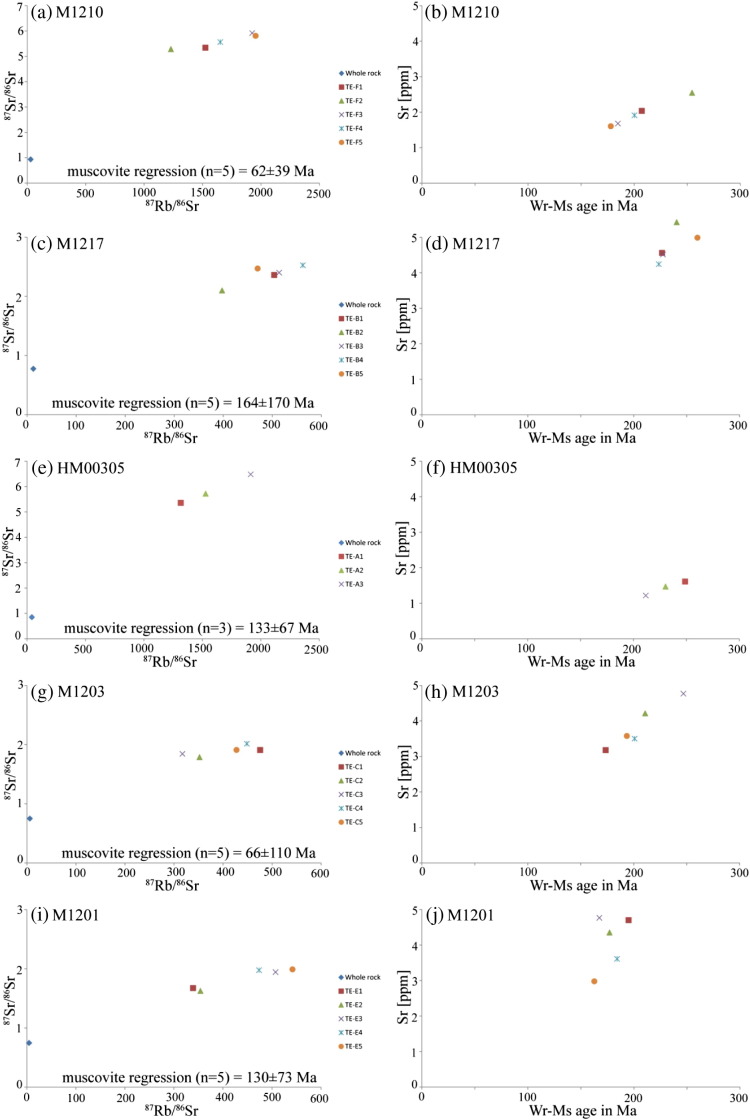
ID-TIMS Rb/Sr data plotted in 87Rb/86Sr vs 87Sr/86Sr space (left column) and Sr-concentrations vs Rb–Sr muscovite–whole rock apparent age (right column) for (a–b) M1210, (c–d) M1217, (e–f) HM00305, (g–h) M1203 and (i–j) M1201. Age values in the left column refer to muscovite-internal regressions. Note the scatter of these around the time of the Cretaceous event and the positive correlation trend of Sr in muscovite with the in muscovite–whole rock apparent age.